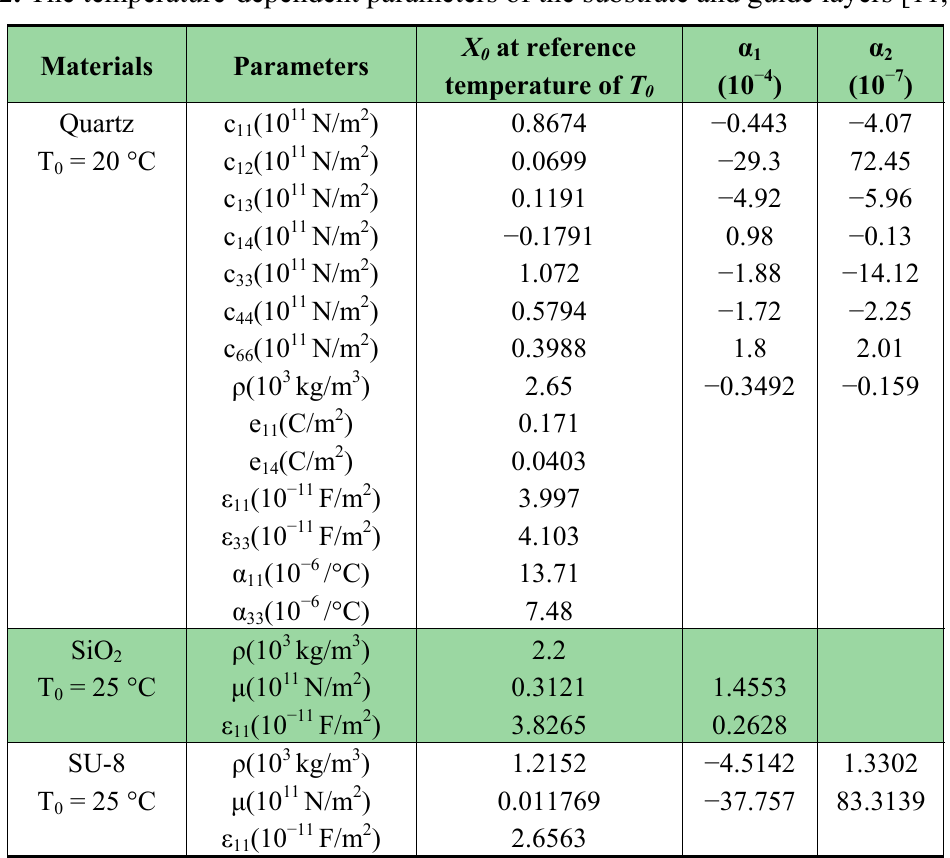
Table 2. The temperature-dependent parameters of the substrate and guide layers